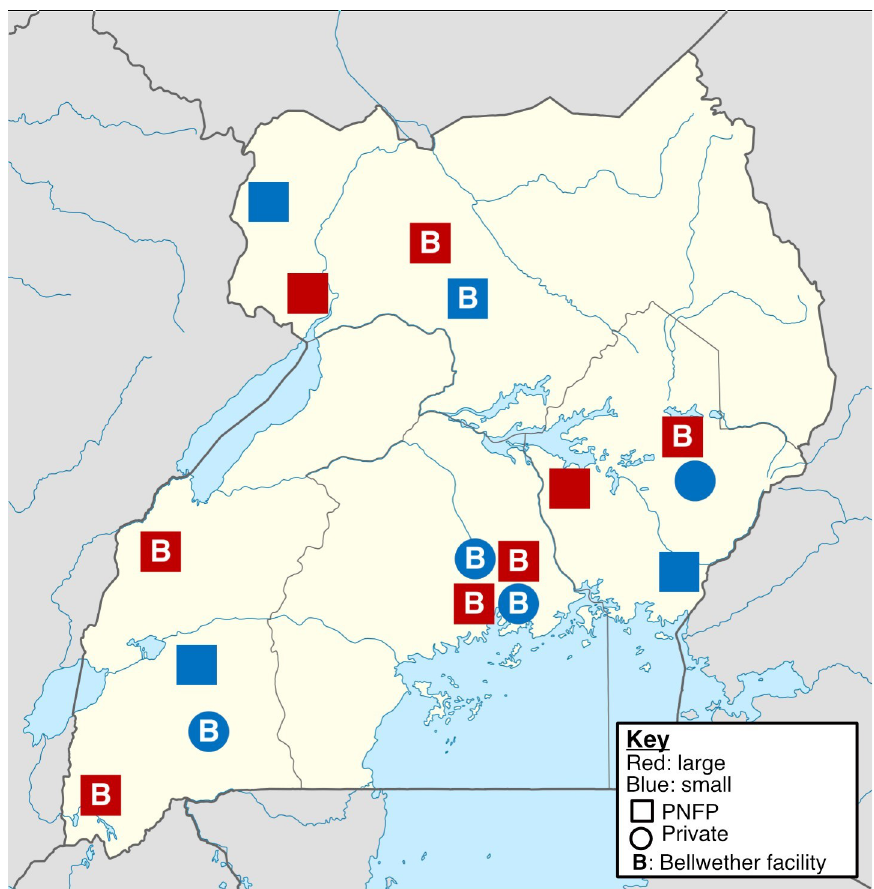
Fig 1. Map of sampled facilities in